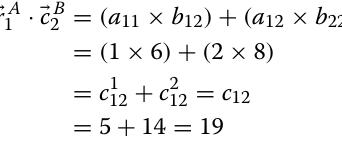
Attack and error